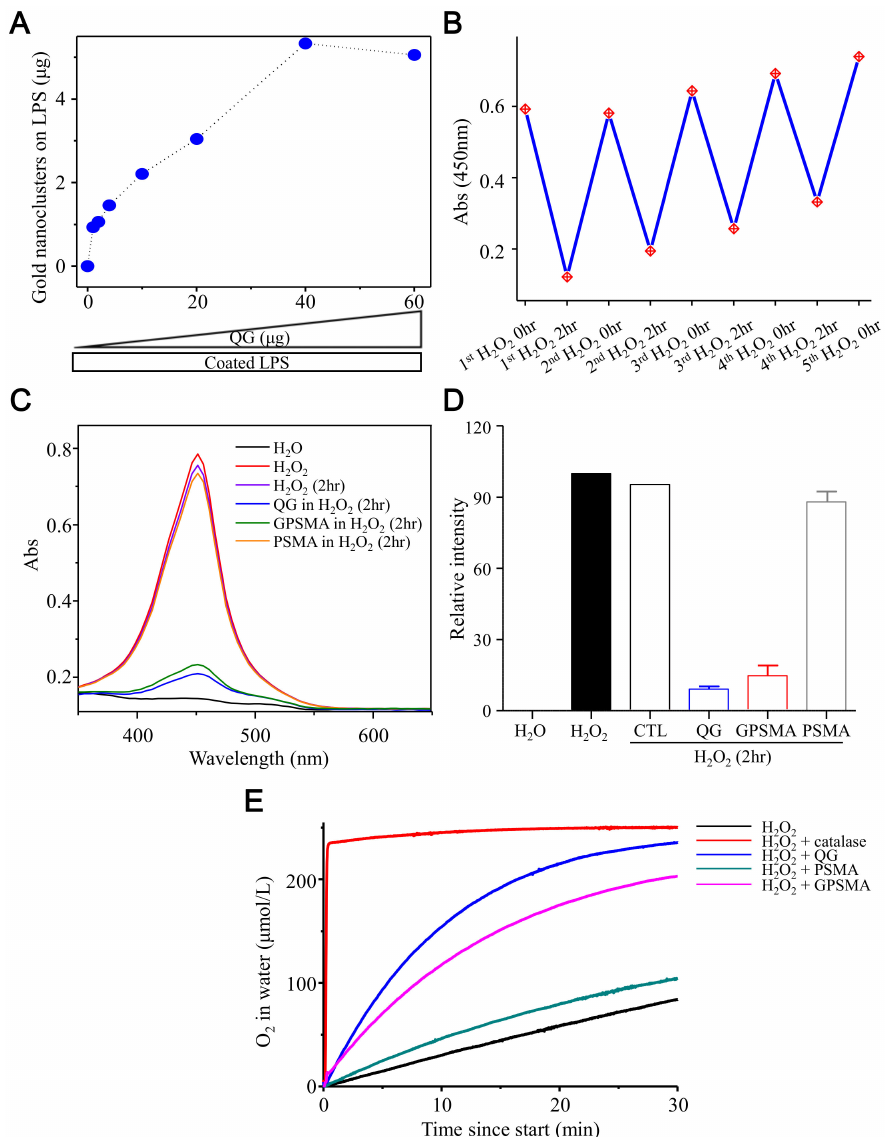
Figure 4. Catalytic assessment of QG and GPSMA. ( A ) Binding of varying amounts of QG to LPSs coated on well plates. ( B ) Potential recycling diagram of QG for catalyzing hydrogen peroxide. ( C ) Examination results of the catalase-like activity of QG, PSMA, and GPSMA using fluorescence spectroscopy. ( D ) The relative absorption intensities of catalase-like activity at 450 nm in each group are shown. H 2 O and H 2 O 2 in their initial state were the negative control and positive control, respectively. ( E ) The measurement results of oxygen-generating kinetics in water after adding 0.1 mM H 2 O 2 to each